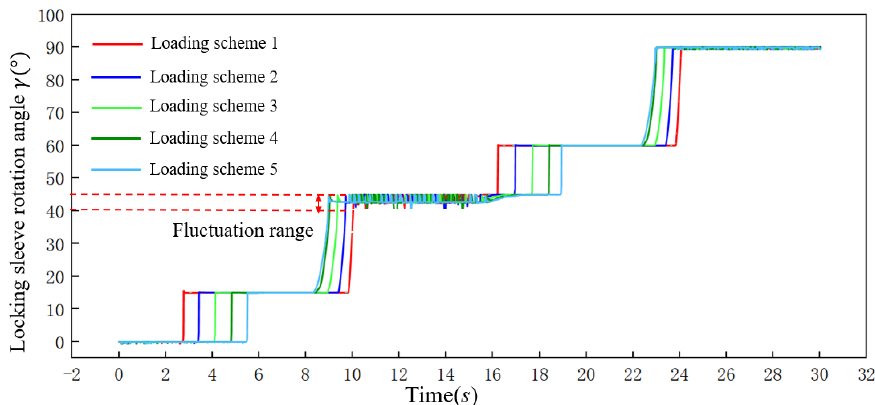
Figure 10. The rotation angle changes with different flow loading schemes.